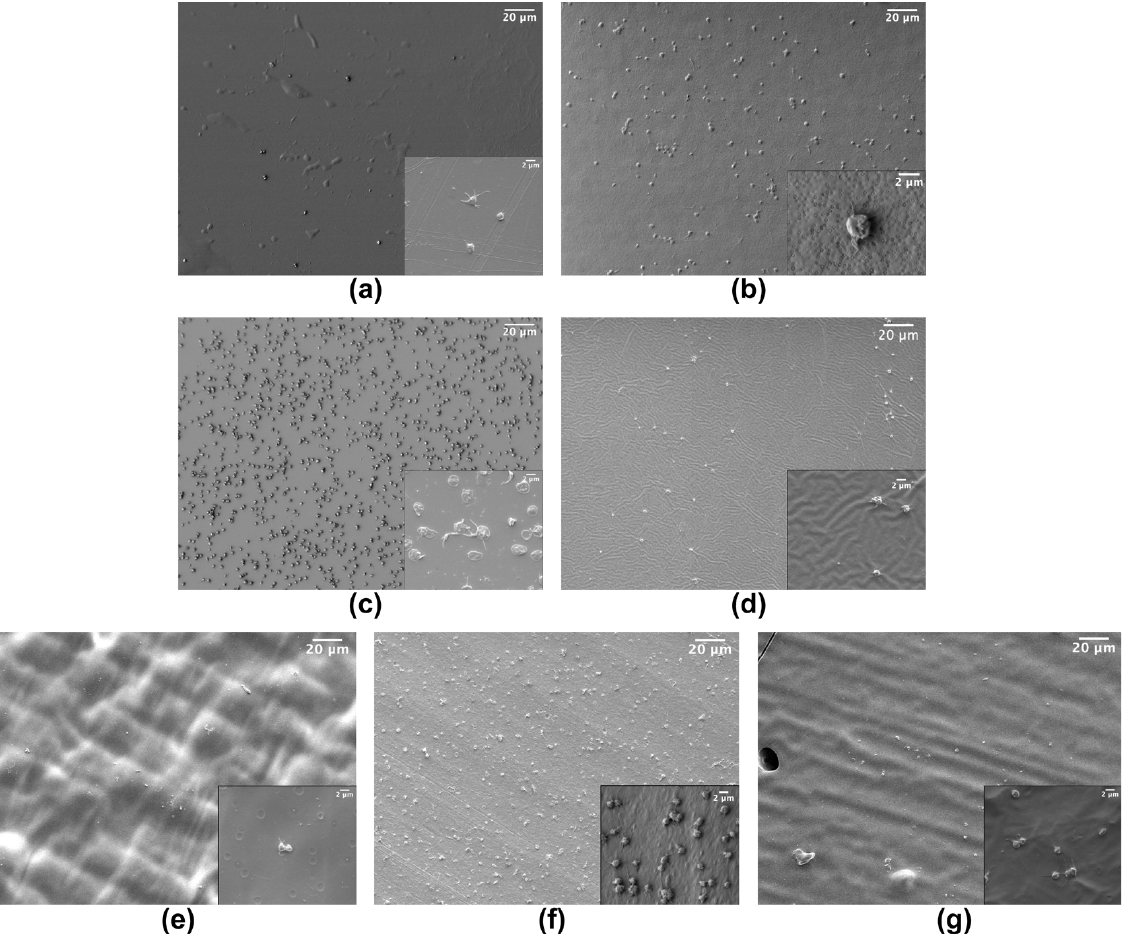
Figure 2. Example of SEM images of platelets adherent to: ( a ) COC; ( b ) PMMA; ( c ) NOA81; ( d ) PDMS; ( e ) PEGDA; ( f ) SpotGP and ( g ) TG. Insets are magnifications of each material (scale bar 2 µm).